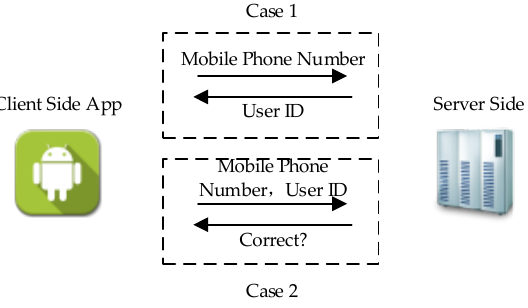
Figure 1. The leakage of the relationship between mobile phone number and user ID.